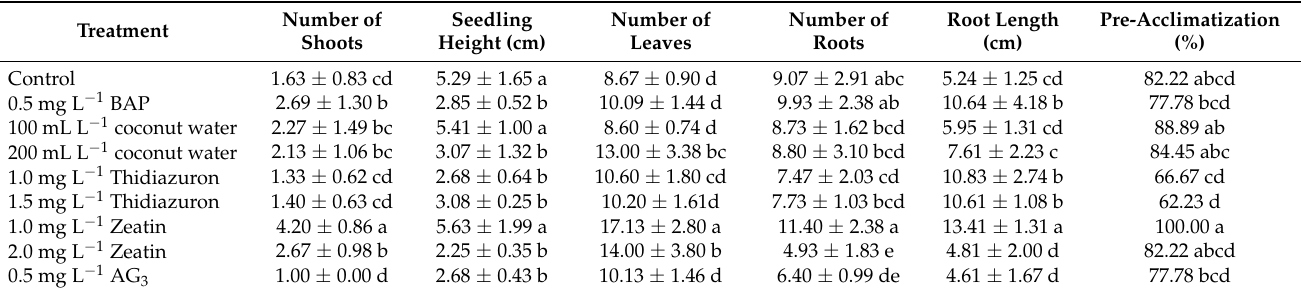
Table 3. Effect of growth regulators on multiplication and pre-acclimation of strawberry seedlings ‘Aroma’